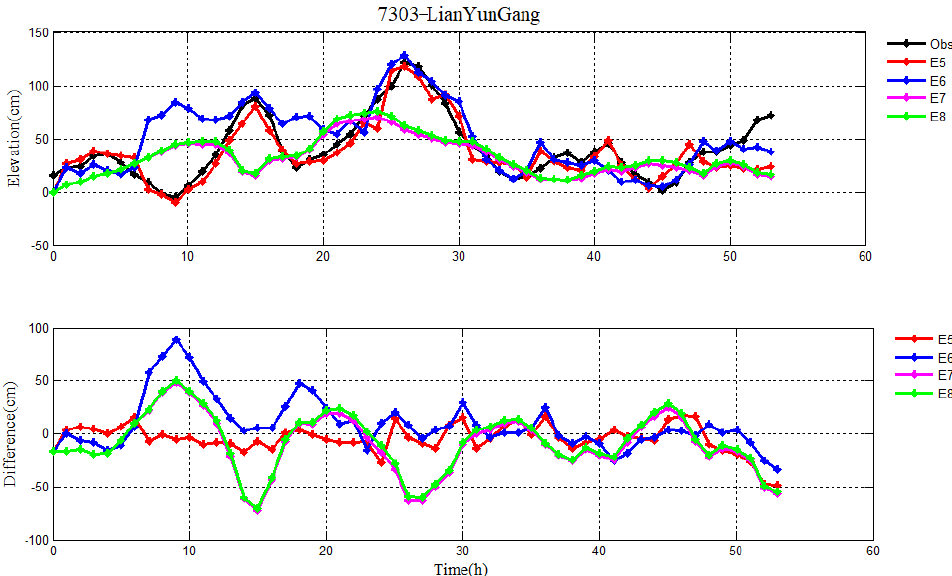
Figure 13. Pure storm surge levels without the astronomical tides in E5 − E8, observation (black line) ( top ), and their differences ( bottom ) during Typhoon 7303 at LianYunGang station.